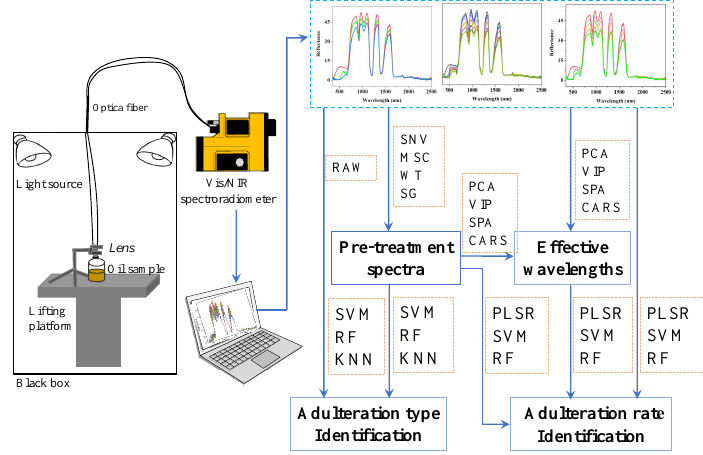
Figure 1. Schematic of measurement of Vis-NIR reflectance